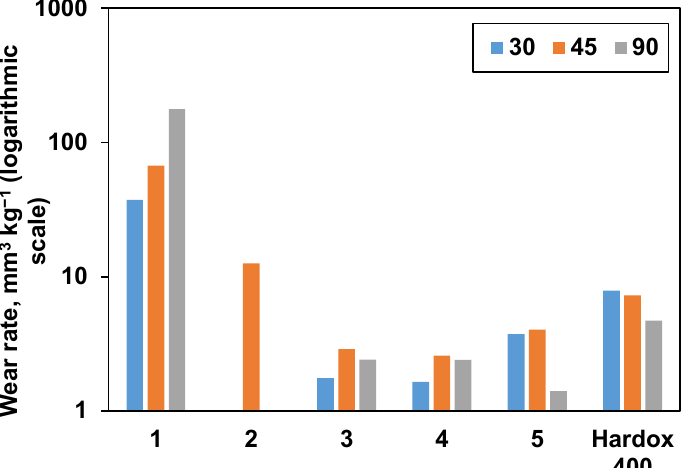
Figure 8. The influence of impact angle on the wear rate of materials. Hardox 400 wear-resistant alloy was used as a reference.